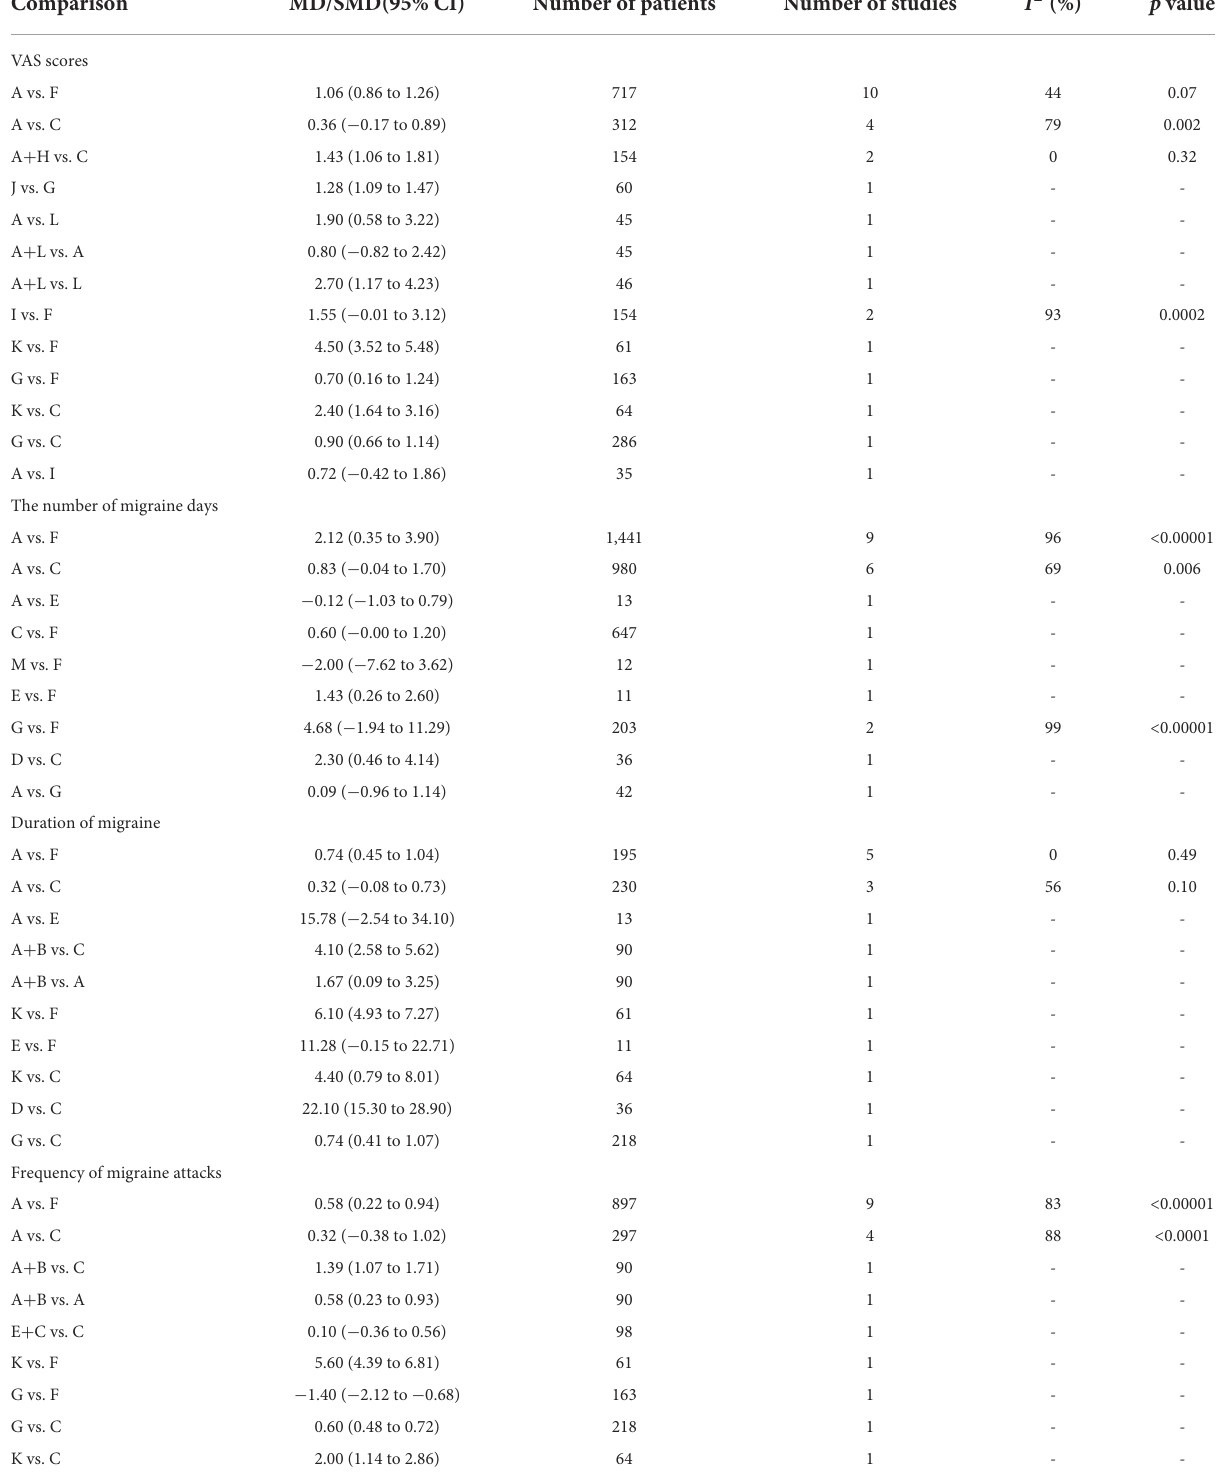
TABLE 4 Pairwise